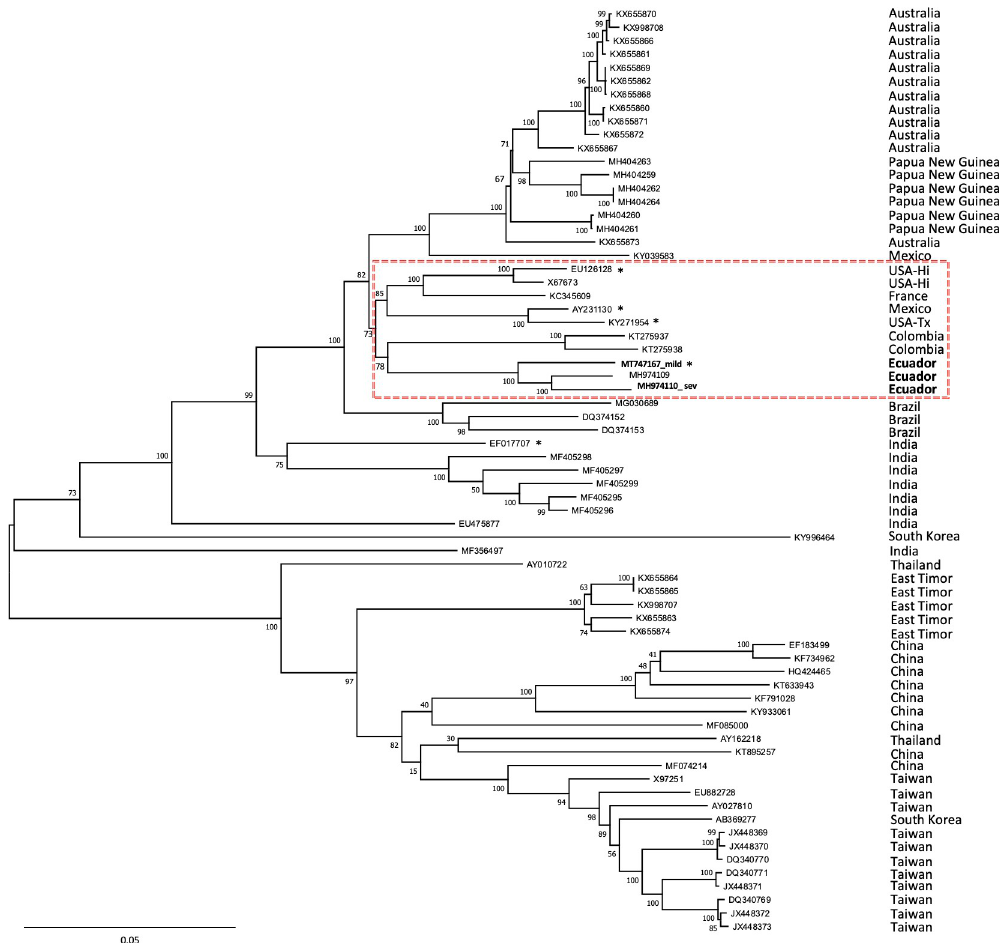
Fig 2. Phylogenetic reconstruction of papaya ringspot virus (PRSV). Sixty-seven PRSV complete genomes were aligned and used for phylogenetic inference using the Maximum Likelihood method with the Tamura-Nei model and bootstrap of 1,000 replicates (shown at each node). Taxa are indicated by accession number. The country where each isolate was reported is shown on the right. Dashed red box indicates a subclade including isolates from Ecuador, Colombia, United States, France and Mexico. Asterisk denotes genomes with the six-nucleotide deletion in the EK region of the coat protein gene.